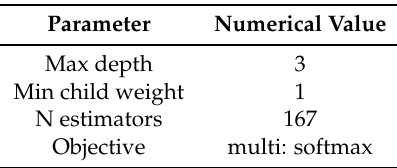
Table 4. Parameters for XGBoost.